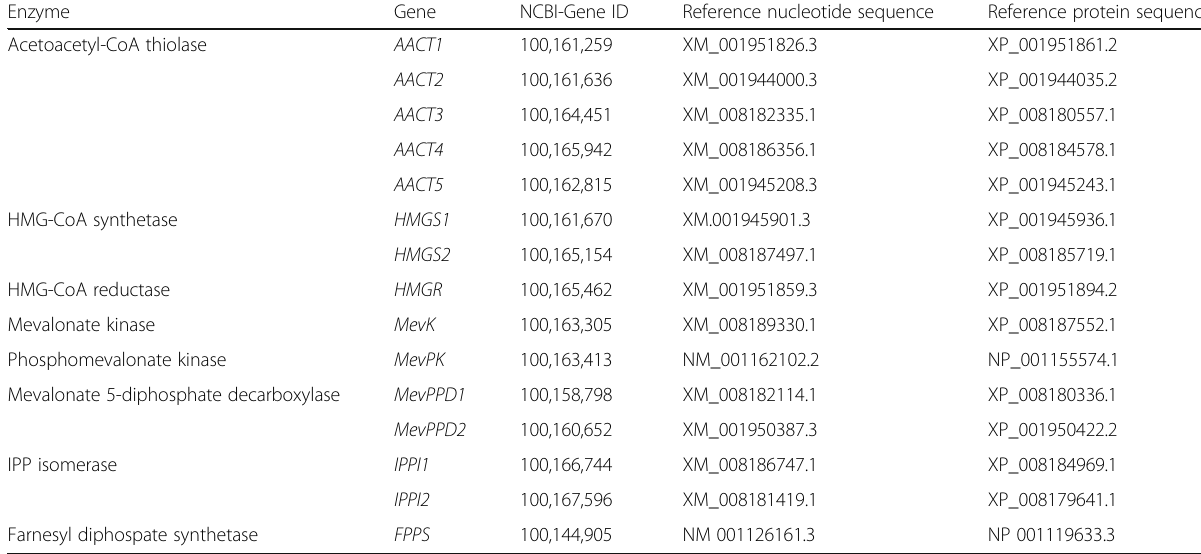
Table 1 List of enzyme genes involved in the monoterpenoid synthesis Enzyme Gene NCBI-Gene ID Acetoacetyl-CoA